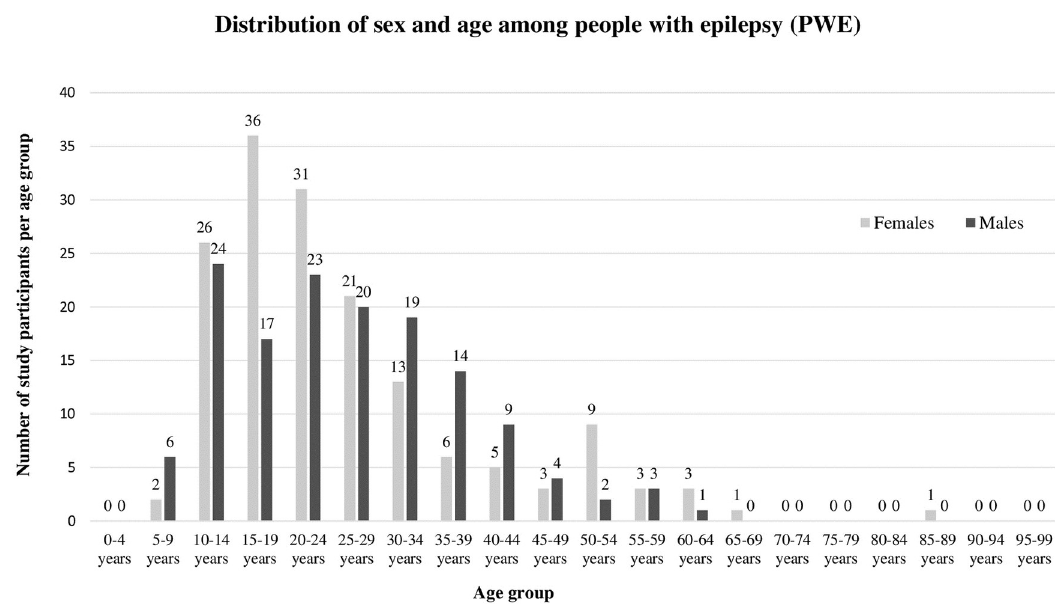
Fig 3. Sex and age distribution of the study